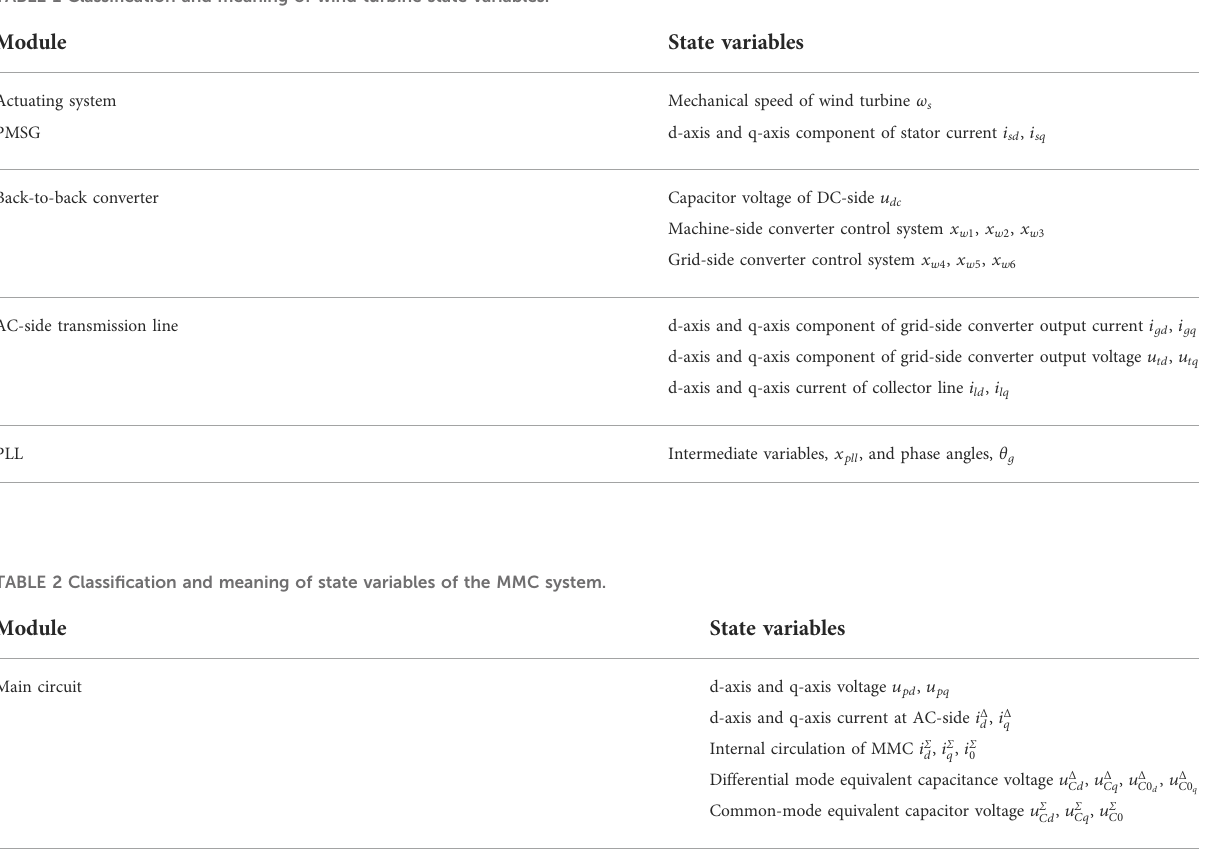
TABLE 1 Classi fi cation and meaning of wind turbine state variables.